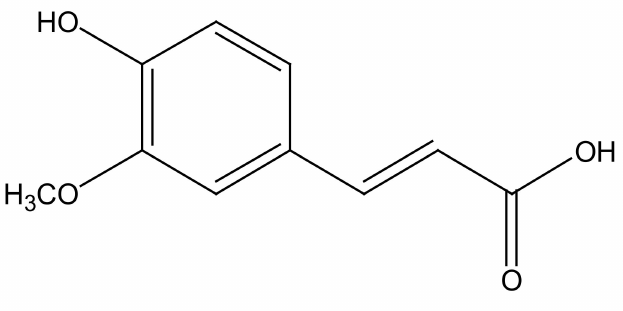
Figure 1. Chemical structure of ferulic acid